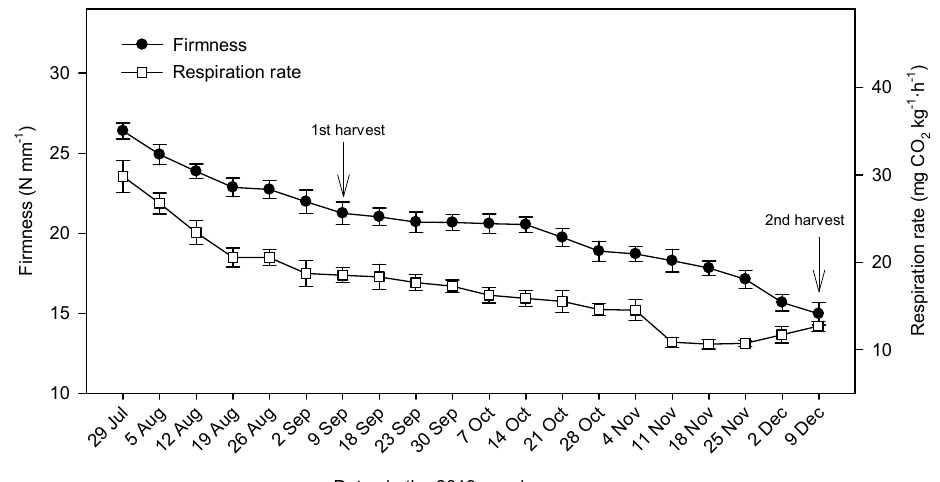
Figure 3. Evolution of firmness and respiration rate represented at the left and right axes, respectively, in lemon fruits during development and on-tree ripening in the 2019 growing season. Firmness is directly related to cell turgor and skin thickness, two crucial characteris- tics for overall fruit acceptance by consumers [32,33]. Values of firmness decreased during postharvest storage for both treatments, although those values of degreening-treated lemon fruits were 20% higher than the non-treated fruits at harvest or day 0. These differ- ences observed were related to the harvest point and the on-tree ripening process, as can be observed in Figure 3. Indeed, regarding the evolution of firmness during postharvest storage, these differences were maintained between both treatments during 28 days of storage (Figure 2C). Firmness loss throughout the fruit development and on-tree ripening as well as dur- ing postharvest storage could be related to the activation of the main hydrolytic enzymes: polygalacturonases, pectin methyl esterases, and cellulases. It has been described that the main role of these enzymes is attributed to the depolymerisation of the main cell wall components of flavedo and albedo tissues, such as pectins, hemicellulose, and cellulose, being that their expressions increased during the fruit senescence process [19,34]. Concerning colour a*, its values ranged from − 20 to − 18 until 11 November, the first harvest date being on 9 September when the lemon fruits were still green (Figure 4). De- greening is a natural process related to the degradation of chlorophylls leading into the biosynthesis of carotenoids, which occurs when temperatures decrease below 13 °C [25], being in accordance with the presented results (Figure 4). Besides, not only the tempera- ture but also the selected cultivar, rootstock, relative humidity and type of soil are key factors that affect this natural process [35]. At the beginning of the storage experiment, the colour was similar for both treatments and no significant differences were observed ( p ≥ 0.05) (data not shown). In addition, the fruit volume gradually increased during the 2019 season (Figure 4).